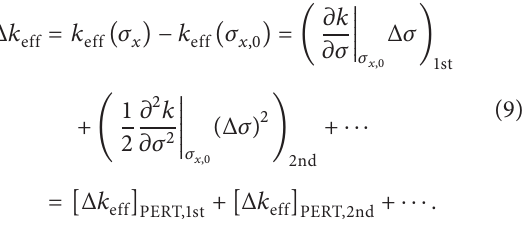
is the cross section perturbed, 𝜎 𝑥,0 is its nominal value, and Δ𝜎 = 𝜎